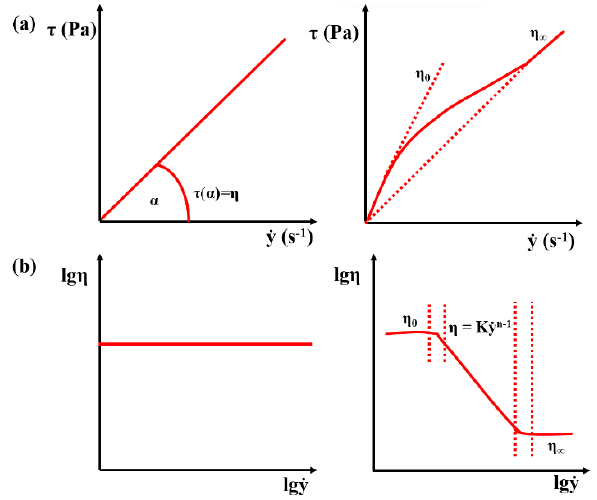
Figure 2. ( a ) Flow and ( b ) viscosity curves for Newtonian and non-Newtonian (shear-thinning) fluids.